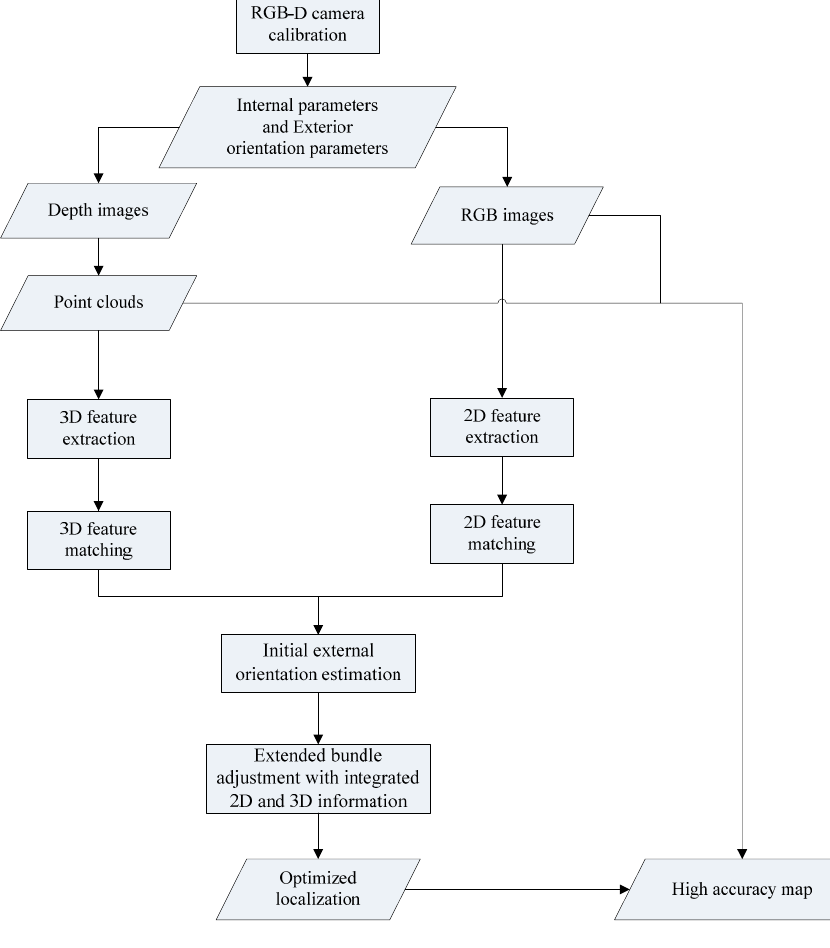
Figure 1. Flowchart of our method.